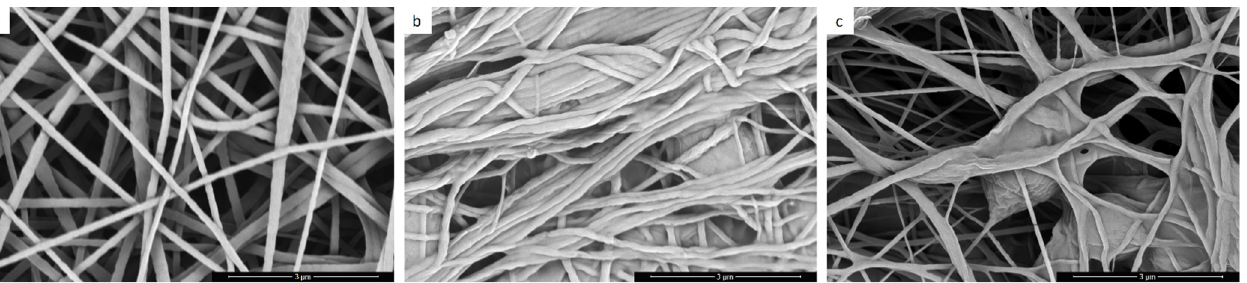
Figure 2. HRSEM images ( a ) pristine PUR without the occurrence of glued parallel fiber bundles or fused bands and layers; ( b ) PUR/TEPA (1 wt.%). A distinct characteristic feature of this sample is parallel bundles of fibers alternating with an irregular network; ( c ) PUR/TEPA (5 wt.%). After in- creasing the TEPA concentration to 5 wt.%, the individual fibers were fused into continuous strips and